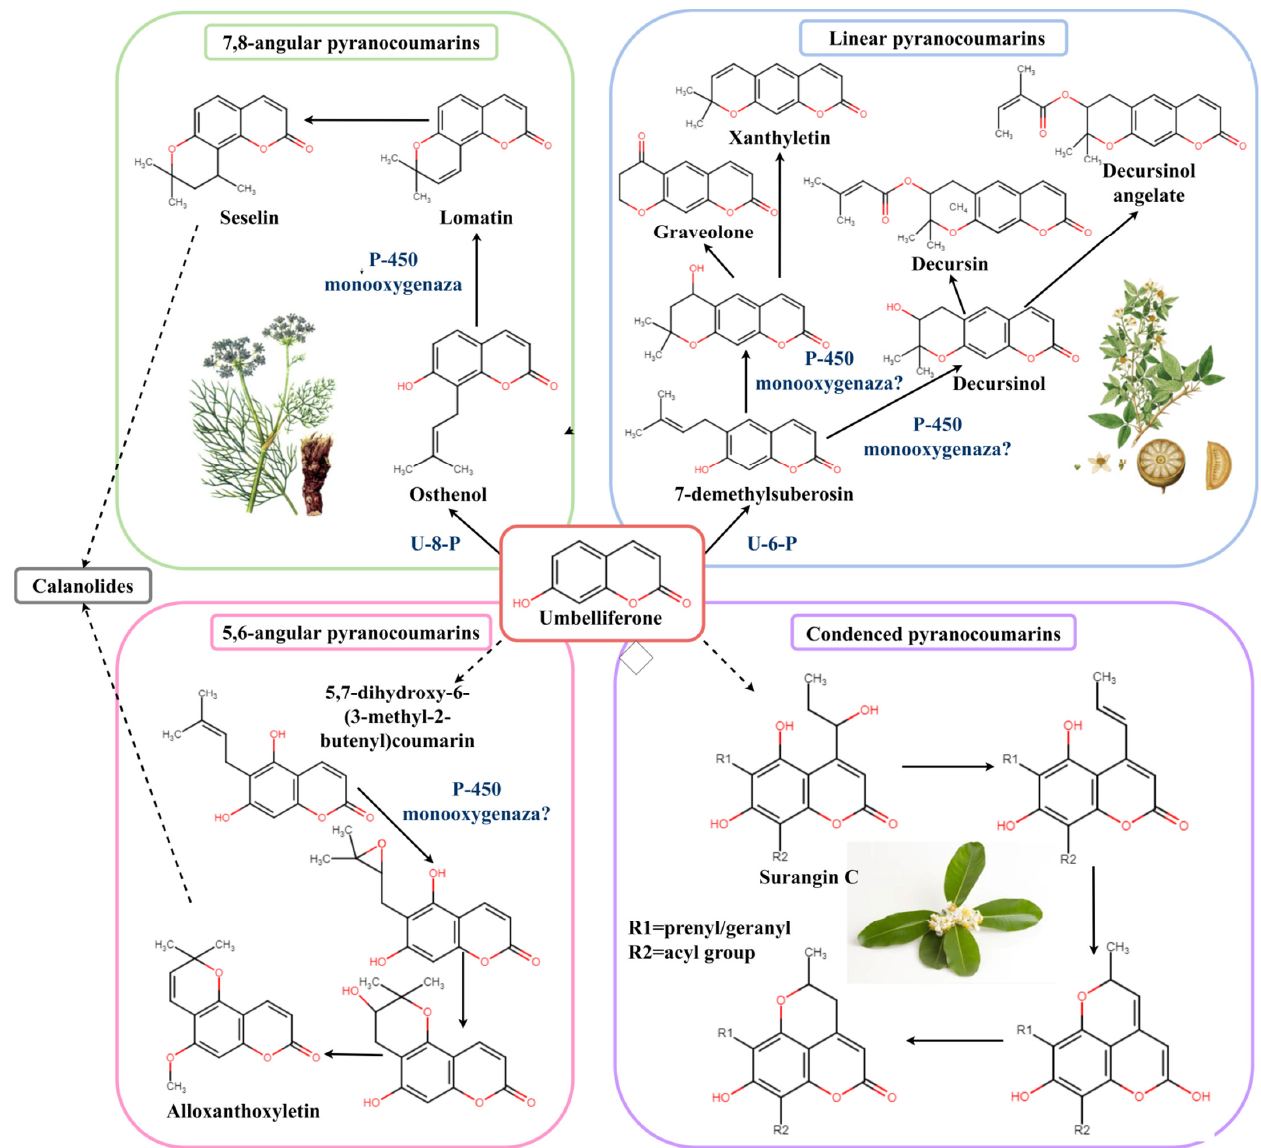
Figure 3. Biosynthesis of pyranocoumarins.